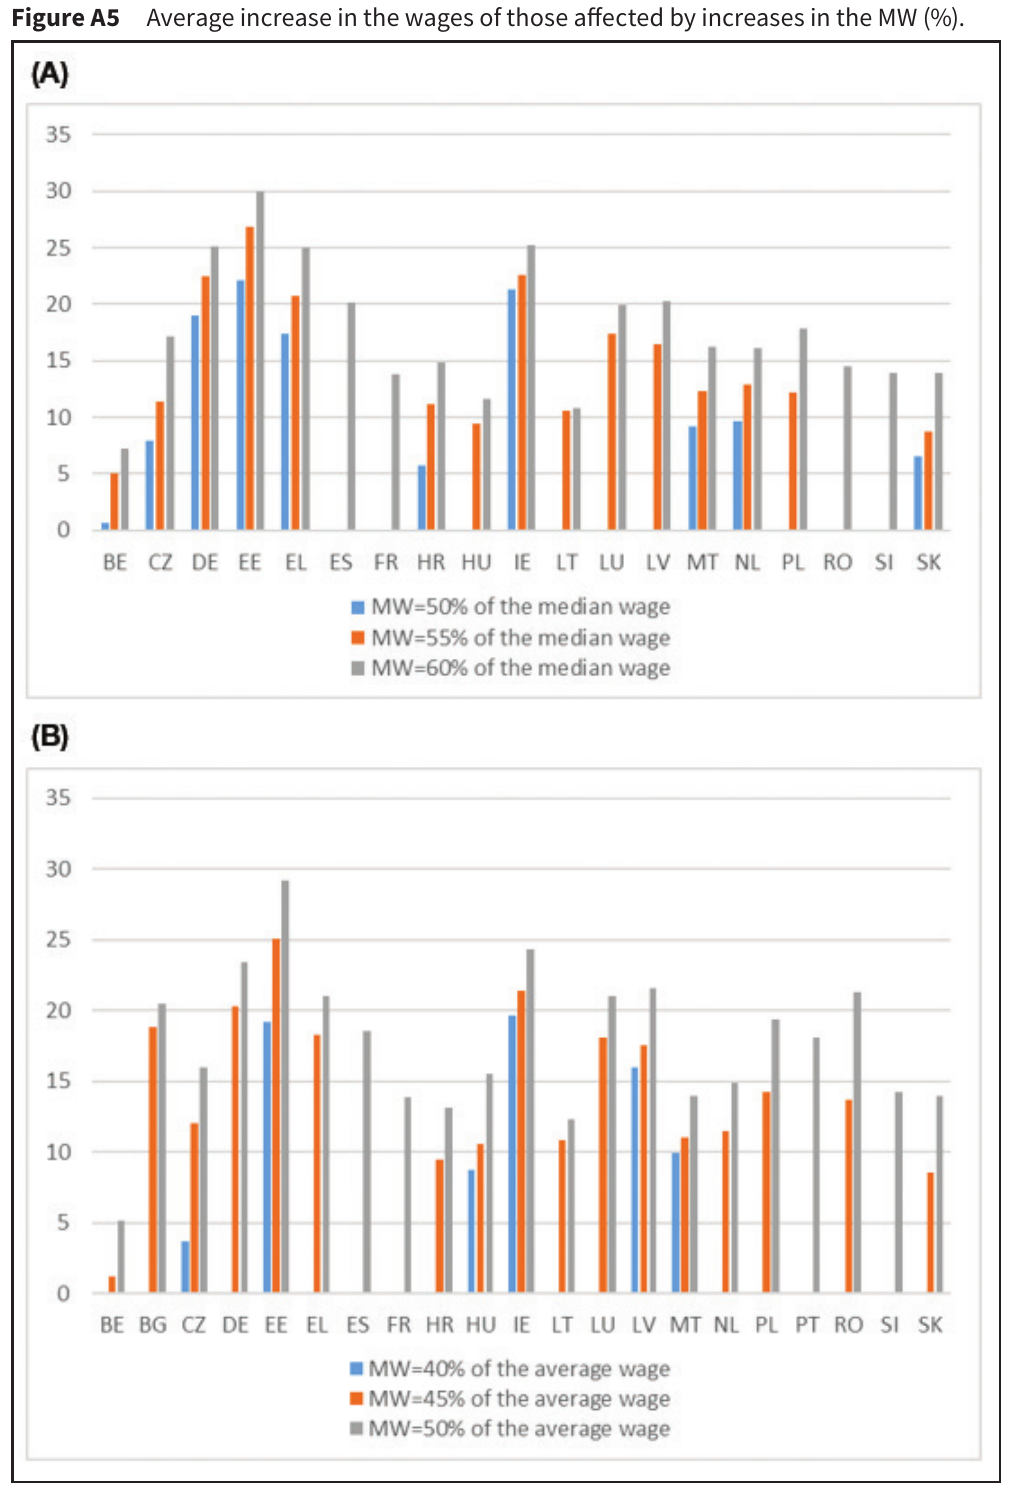
Figure A5 Average increase in the wages of those affected by increases in the MW